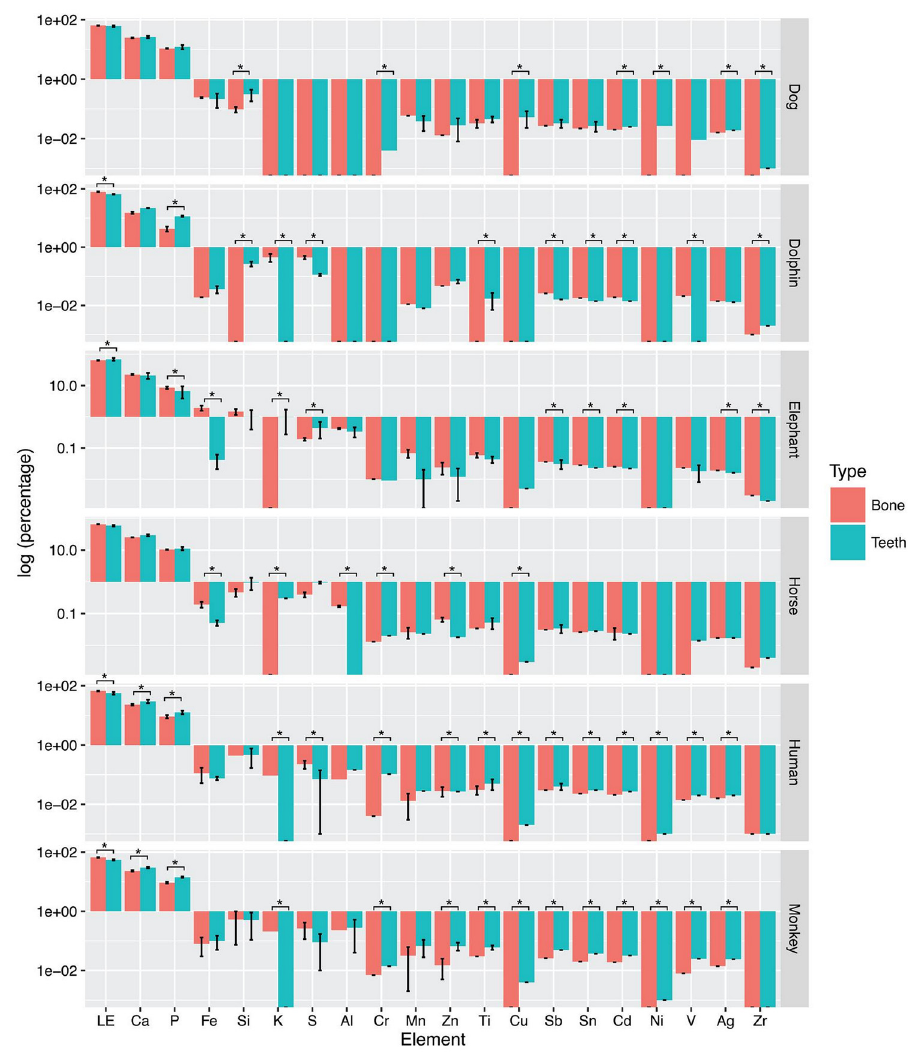
Fig 5. The percentage of multiple elements in various species. The bar express mean ( ± standard deviation (SD)) percentages of elements in dog, elephant, horse, human, monkey and dolphin teeth and bone. * indicates a significant difference at P <